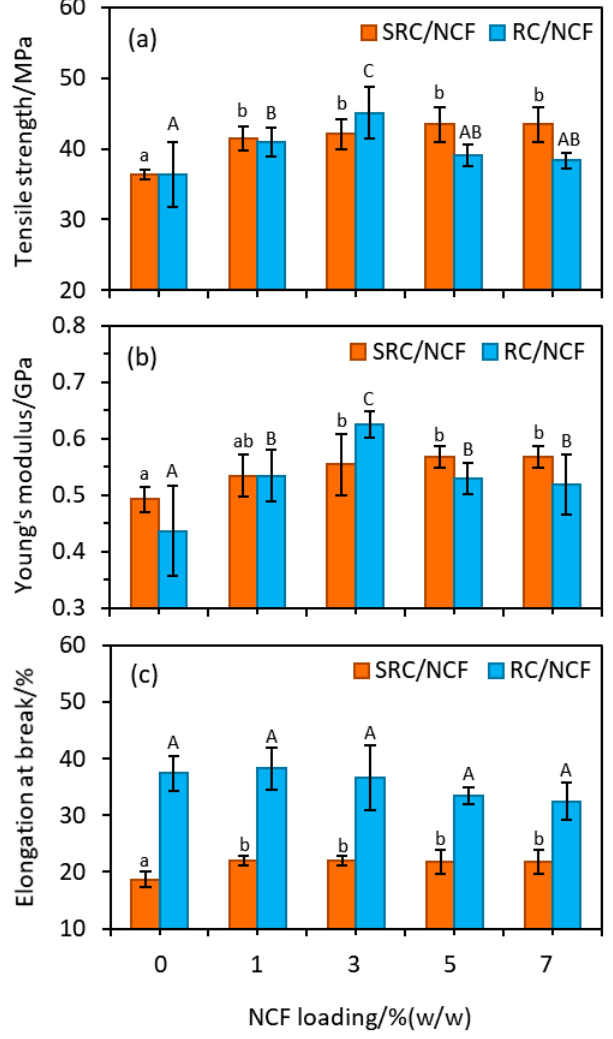
Figure 4. Plots of ( a ) tensile strength, ( b ) Young’s modulus, and ( c ) % elongation at break for the SRC / NCF and RC / NCF films. Values are plotted as the mean with one standard deviation error bar. Any two labelled with the same letter are not significantly different ( p < 0.05), as determined by a Duncan test.